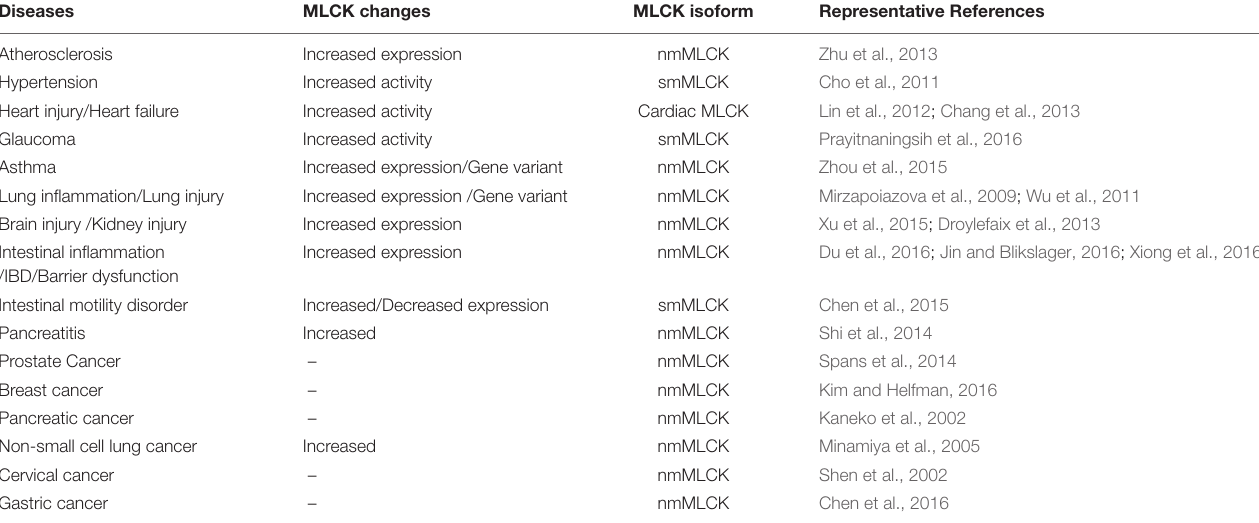
TABLE 1 | Role of myosin light chain kinase (MLCK) in selected